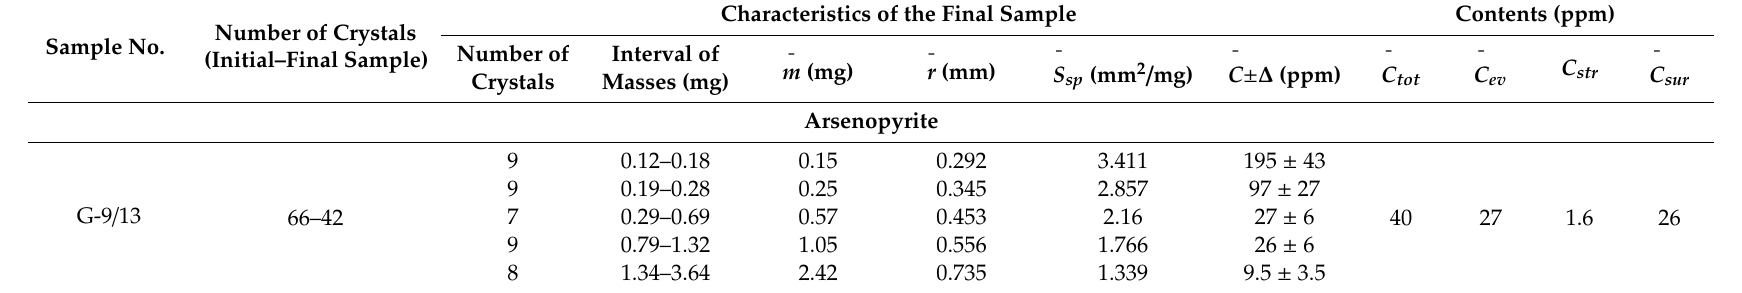
Table 4. Results of palladium analysis of single crystal size selections of arsenopyrite and pyrite from vein, streaky-vein and veinlet-disseminated ores of the Natalkinskoe